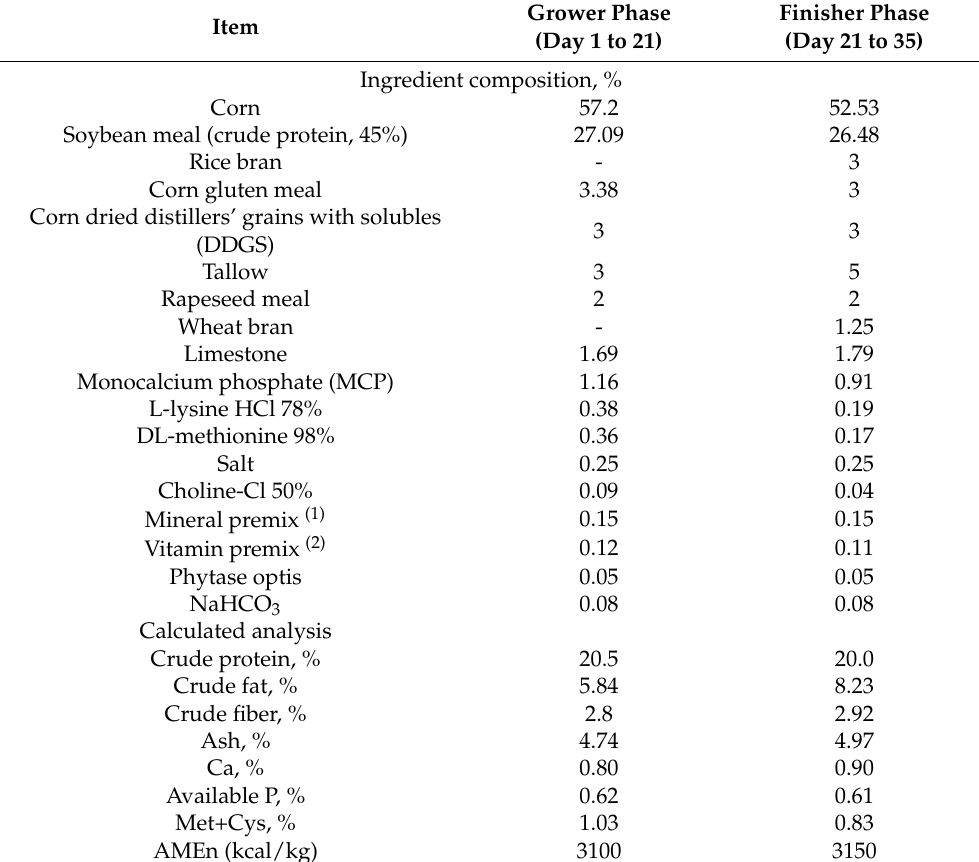
Table 1. Ingredients and nutrient composition of the basal